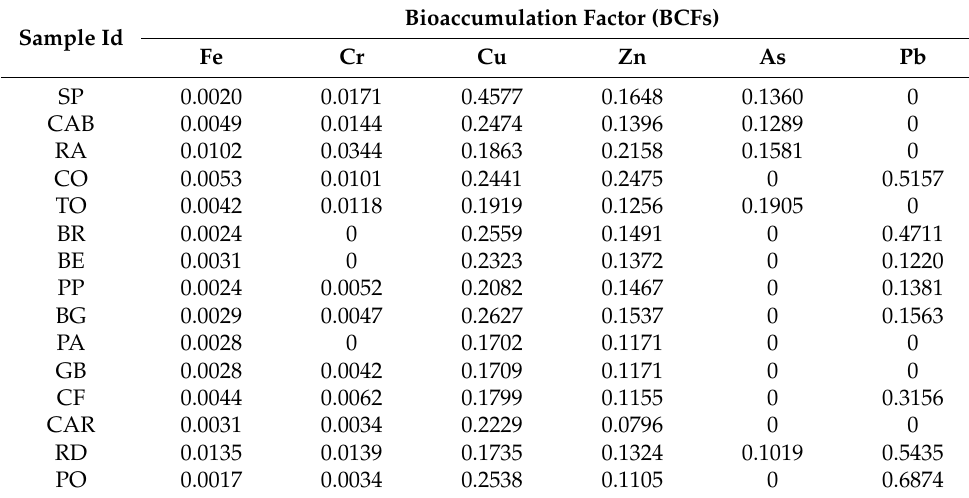
Table 6. Estimated value of Bioaccumulation factor of heavy metals (HMs) from soil to edible part of the vegetable samples.